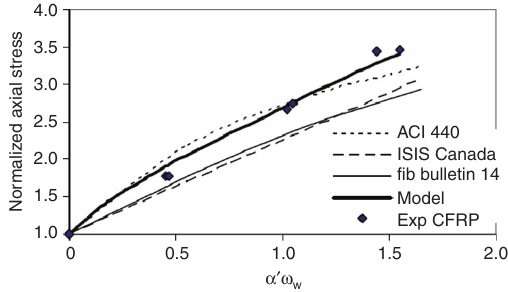
Figure 15 Confinement effectiveness versus lateral jacket